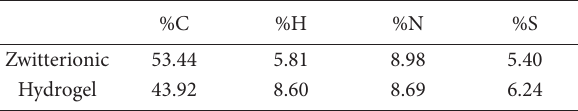
Table 3. Total elemental analysis of two synthesised polymer resins. %C